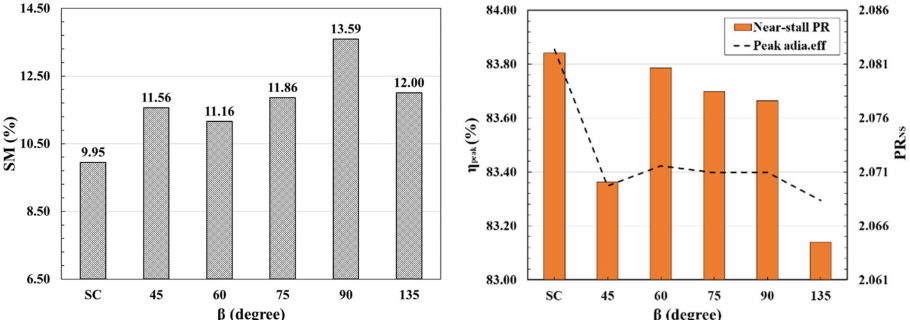
Figure 11. Effects of inclined angle on aerodynamic performance.